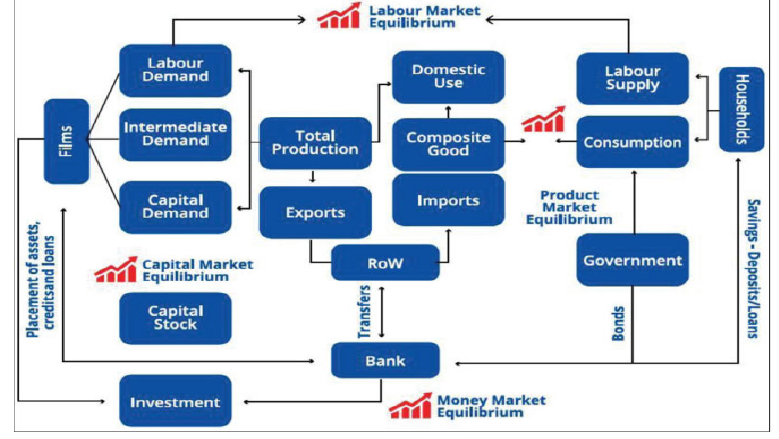
Figure 4. GEM ‐ E3 ‐ ISL structure [22]. Figure 4. GEM-E3-ISL structure GEM ‐ E3 ‐ ISL represents a bottom ‐ up approach for electricity sector and the GEM ‐ E3 ‐